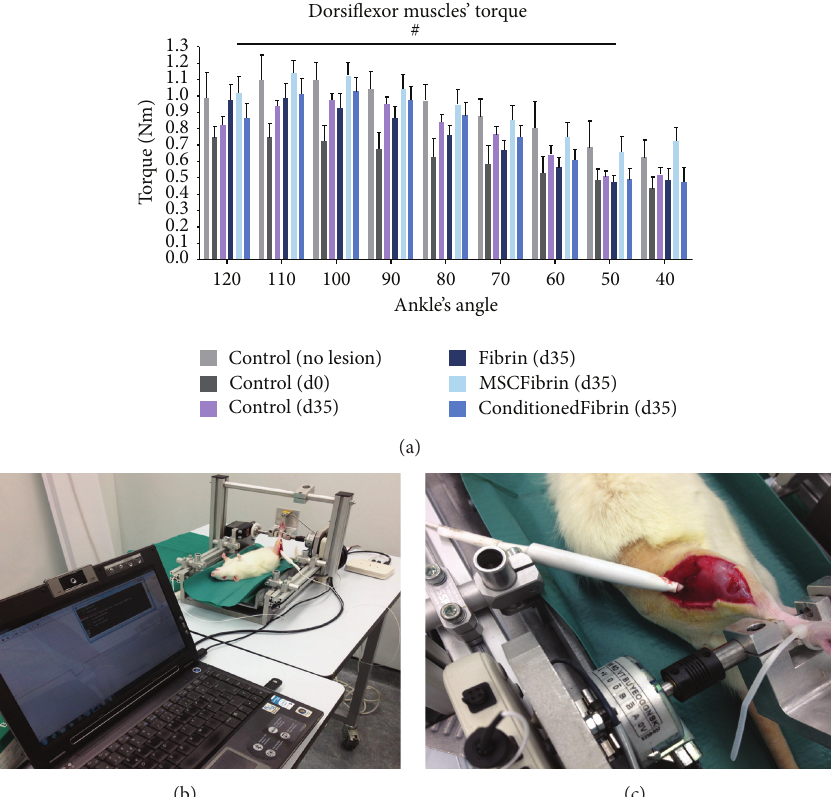
Figure 6: Dorsiflexor muscles’ torque at different ankle joint angles for the rats from the Control and treatment groups (after choosing fibrin glue—Tisseellyo as the preferred vehicle)